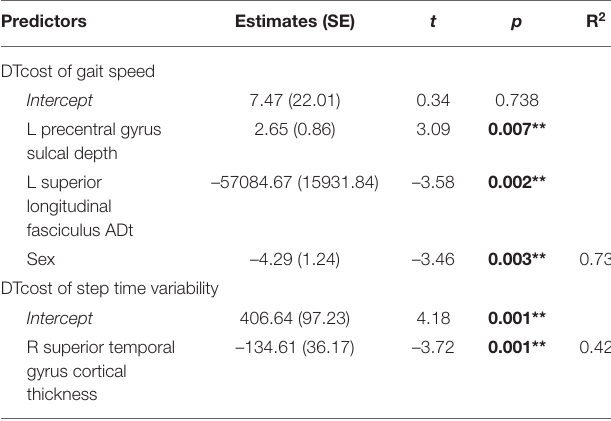
TABLE 7 | Stepwise multiple regression results for the best models of DTcost of gait in older